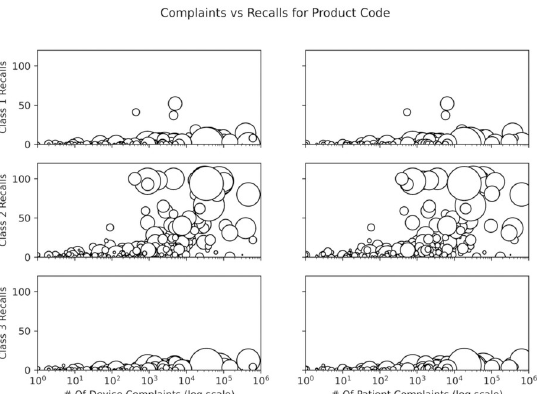
Fig 3. Scatter plot of device complaints (since 2006, as the TPLC database retains data for only 15 years) versus recalls for the product codes associated with the 2,721 devices from 2020. Recalls were split into Class I (most severe), II, and III (least severe), and complaints were divided between device issues and consumer complaints. Complaints were projected onto a log scale because a few product codes had very large numbers of complaints. The size of each point corresponds to the number of different devices in that product